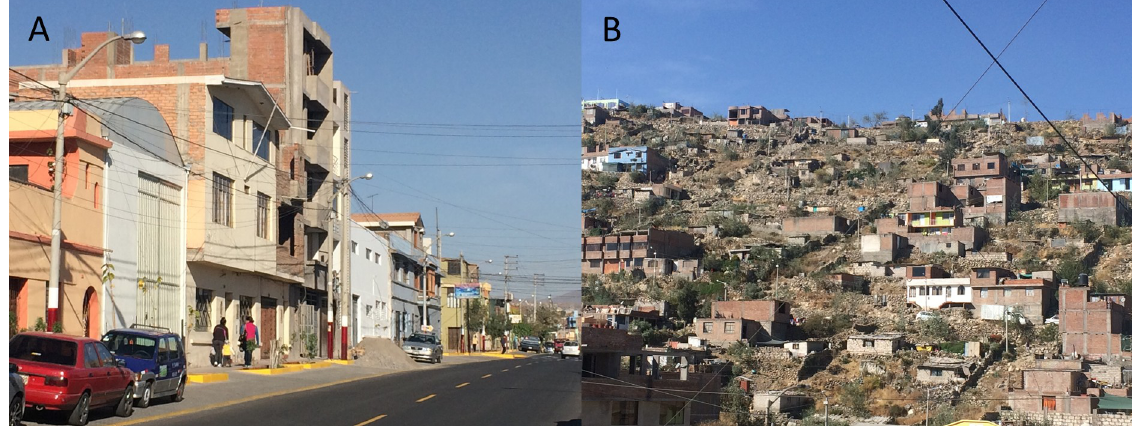
Fig 1. Study communities display landscape heterogeneity. A: Urban area. B: Peri-urban